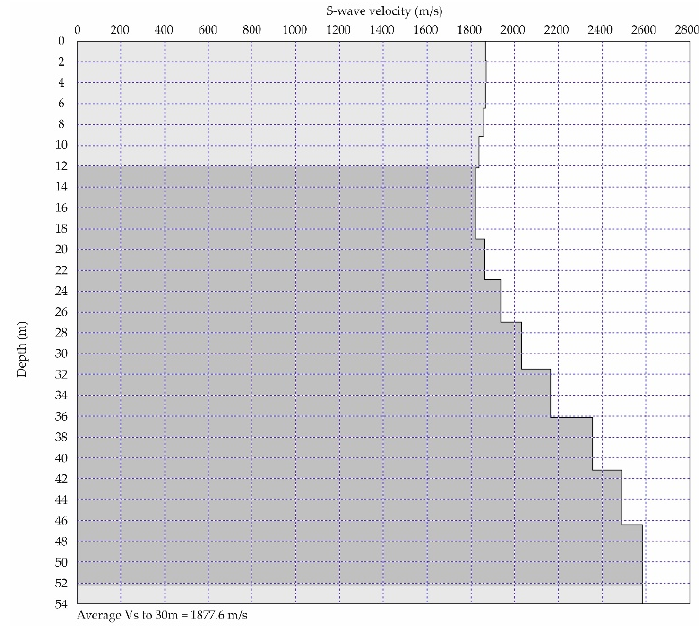
Figure A2. 1D Vs model derived from the MASW technique at MDRA station.